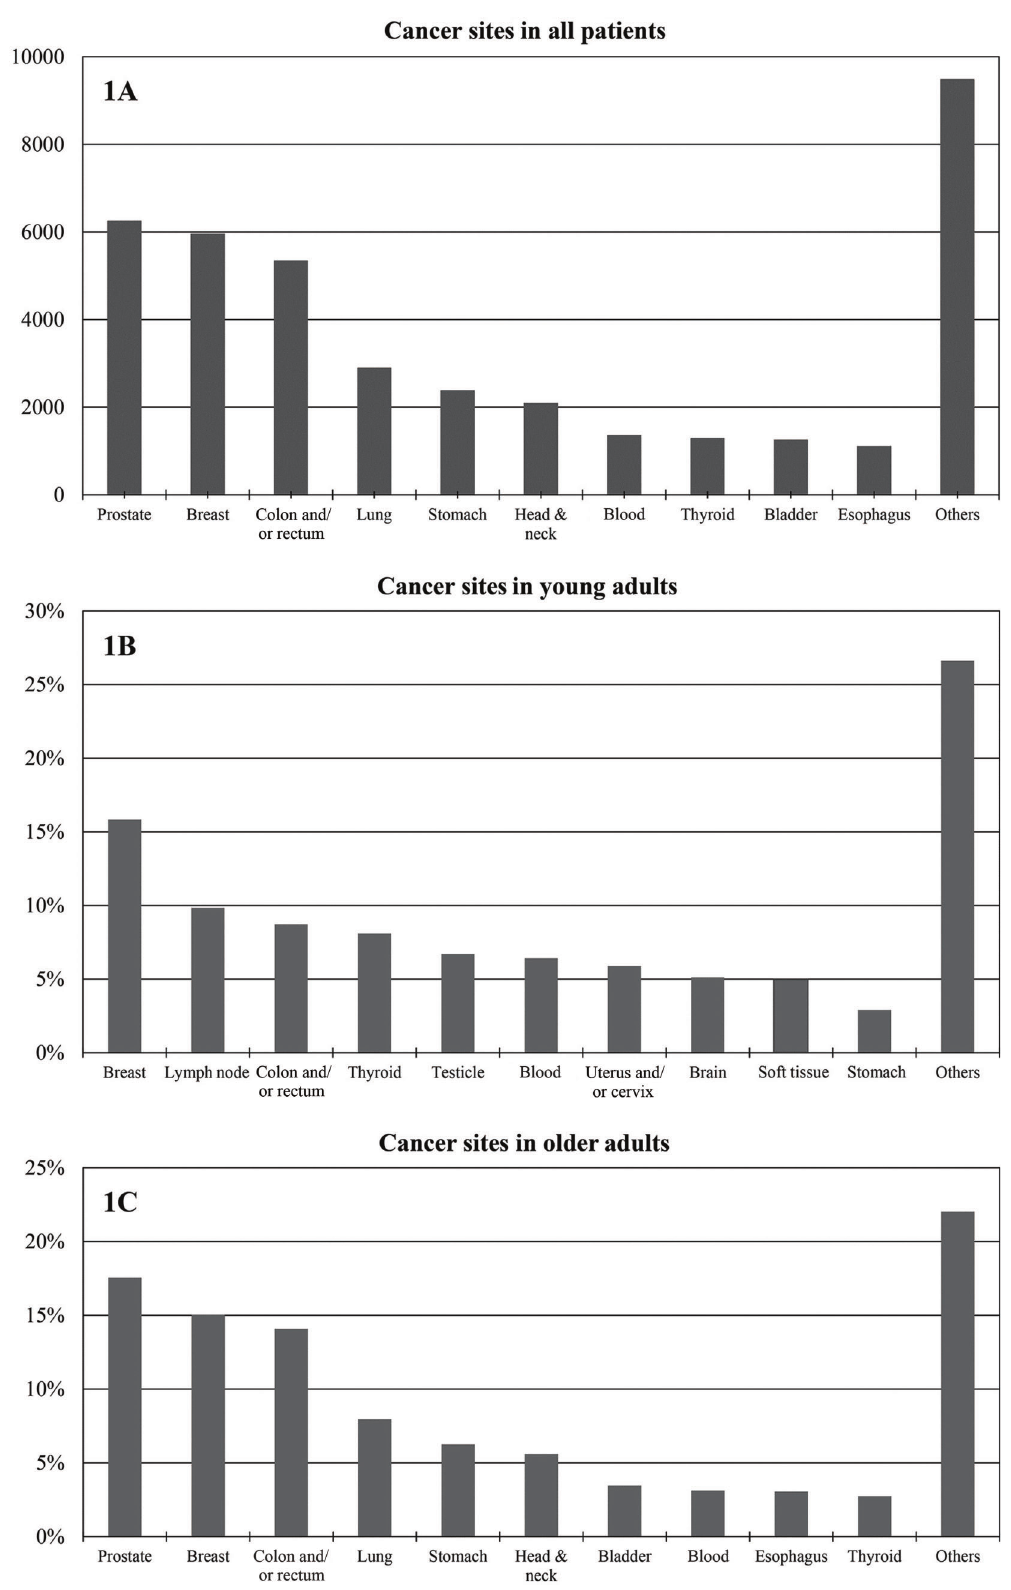
Figure 1 - Cancer sites in all patients. (1A) : Most frequent tumor sites ( n ) in all patients registered at the ICESP (May 2008 to April 2014); (1B) : Most frequent tumors (%) in YA (18 – 39 years); 1C: Most frequent tumors (%) in older patients ( X 40 years).